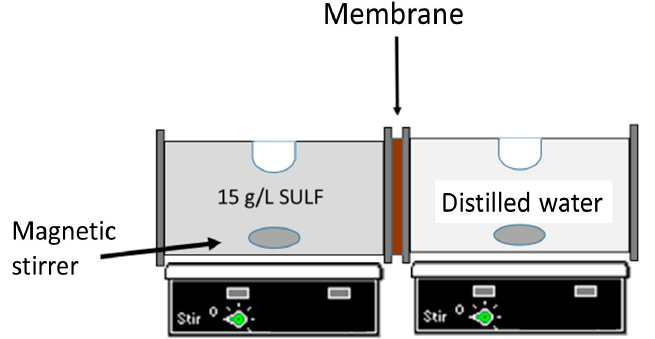
Figure 2. Experimental set-up used for drug permeability measurements.